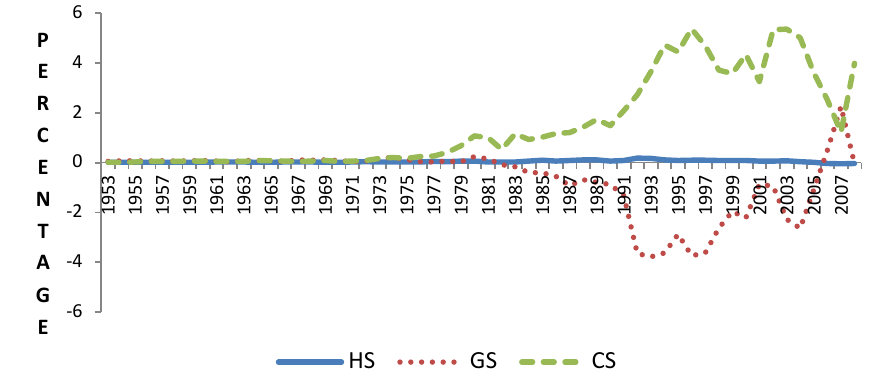
FIGURE 3: Ratio of Government, Household and Corporate Savings to GDP Source: South African Reserve Bank (SARB) Online Database